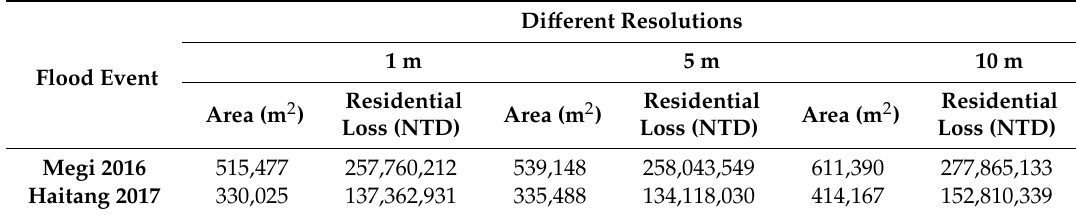
Table 3. Flood losses from di ff erent spatial resolutions.